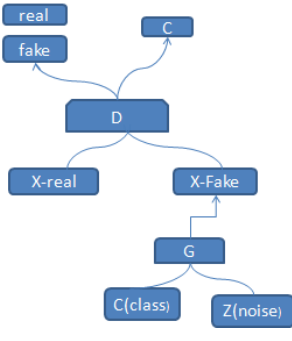
Fig.6. InfoGAN 3.7